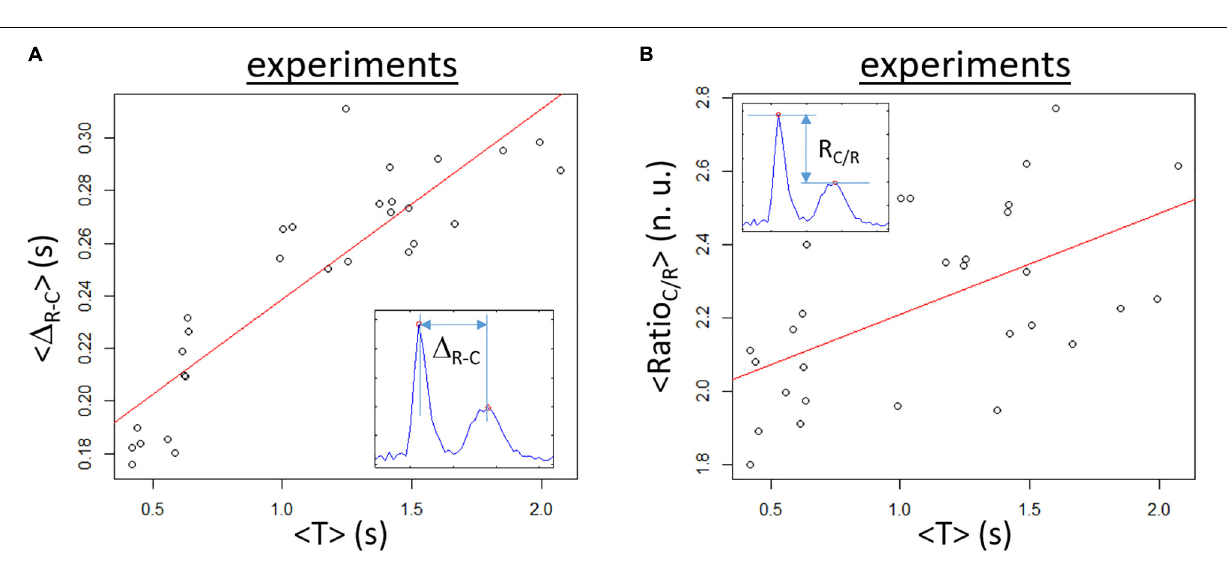
FIGURE 6 | Similar to Figure 5 but for simulation results obtained after 30 (blue line) and 60 s (red line) of simulation. (A) Rapidly increasing (cid:49) R - C for short PCL increase followed be a rapid decrease and a long and slow increase when increasing the PCL. (B) Ratio C / R shows a clear biphasic waveform starting with a small value for short PCL which rapidly increases to a maximum value for PCL around 420 ms followed by a slower decrease while PCL increases. The maximum value of Ratio C / R is smaller at 60 s compared to 30 s indicating the part of the biphasic shape is due to transient dynamics.